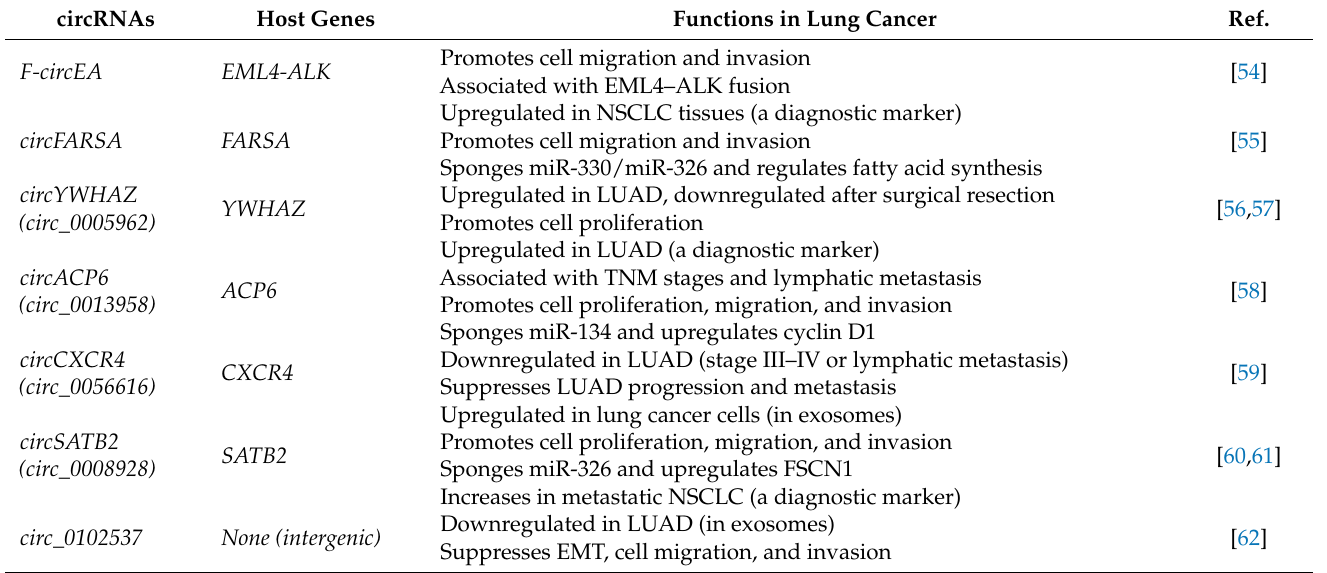
Table 1. List of circulating circRNAs in lung